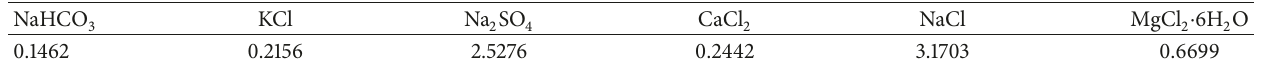
Table 4: Composition of the Korla soil simulated solution (g/L).